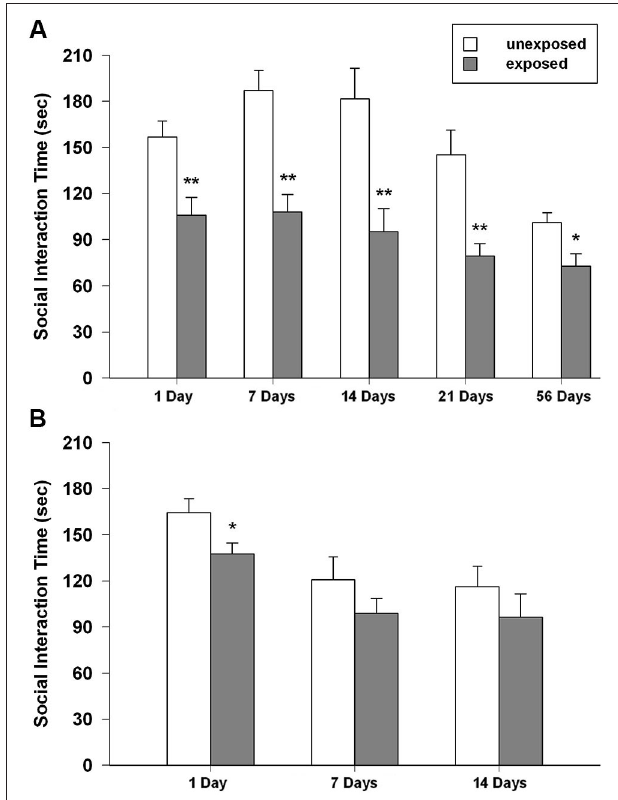
FIGURE 5 | Time spent in social interaction of unexposed and exposed rats 1, 7, 14, 21 and 54 days the exposure to the stressor ( n = 8–11). (A) Isolated, (B) social-housed animals. Data are expressed as mean + SEM (* p < 0.05; ** p < 0.01).